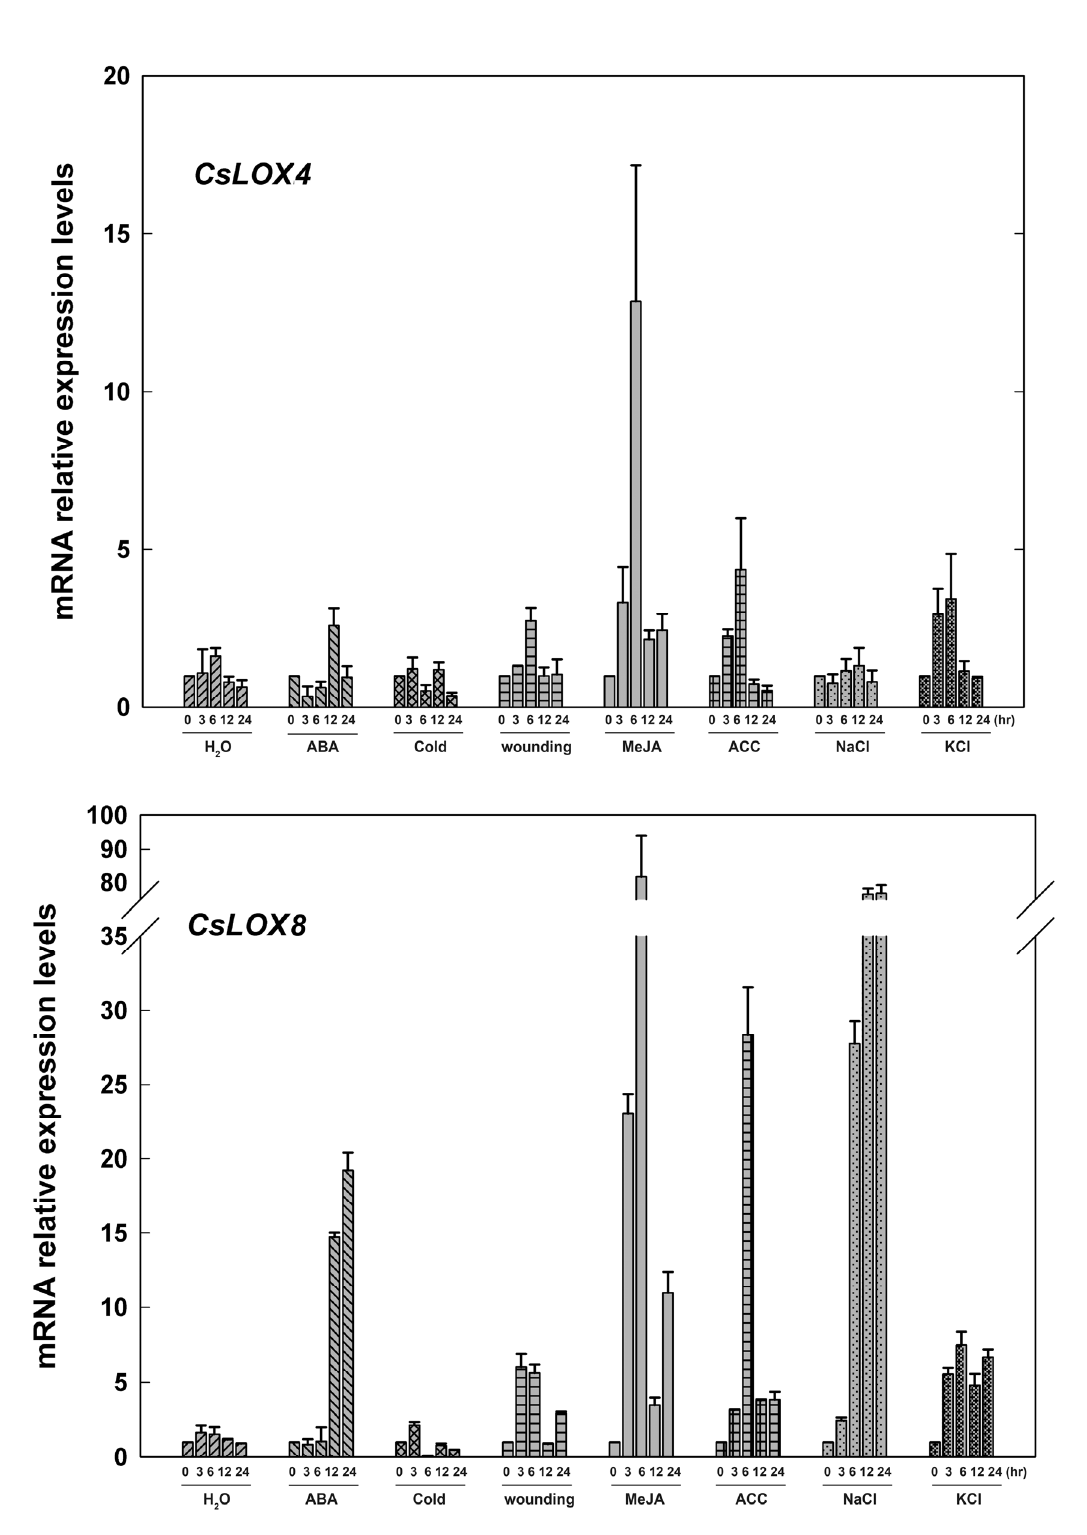
Figure 5. Expressions of CsLOX4 and CsLOX8 in cucumber leaves at various time points under treatments with H O, ABA (100 μ M), cold (4 °C), wounding, MeJA (100 μ M), ACC 2 (100 μ M) NaCl (200 mM) and KCl (200 mM) were analyzed by Real-time PCR. A cucumber actin gene CsACT (Csa017310) was detected as internal reference. Data represent the mean ± SD of three independent biological